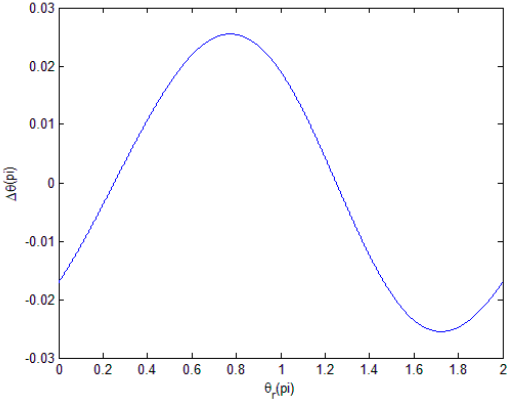
θΔ in one period of